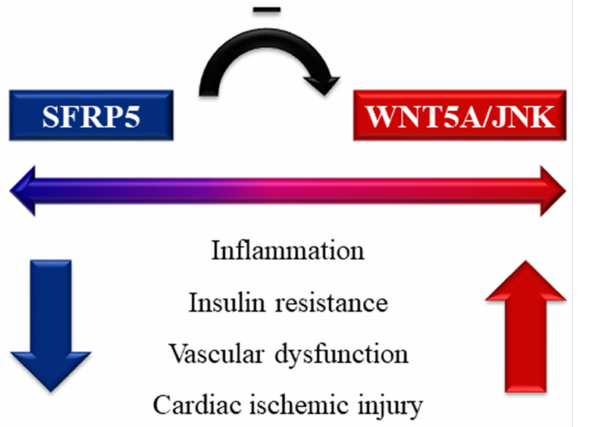
Figure 4. Schematic view on the association of secreted frizzled-related protein 5 (SFRP5) and wingless-type family member 5a (WNT5A)/c-Jun N-terminal kinases (JNK). WNT5A and the down- stream JNK signaling facilitate inflammation and cardiometabolic impairment, which is antagonized by